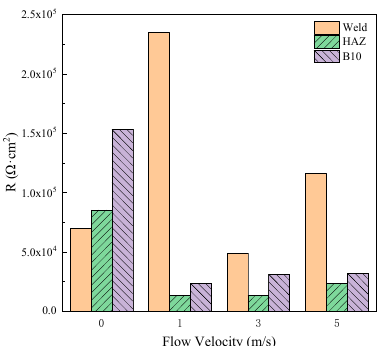
Figure 11. Comparison of corrosion resistance of three zones of 90-10 cupronickel welded joints in different flowing rates of seawater.